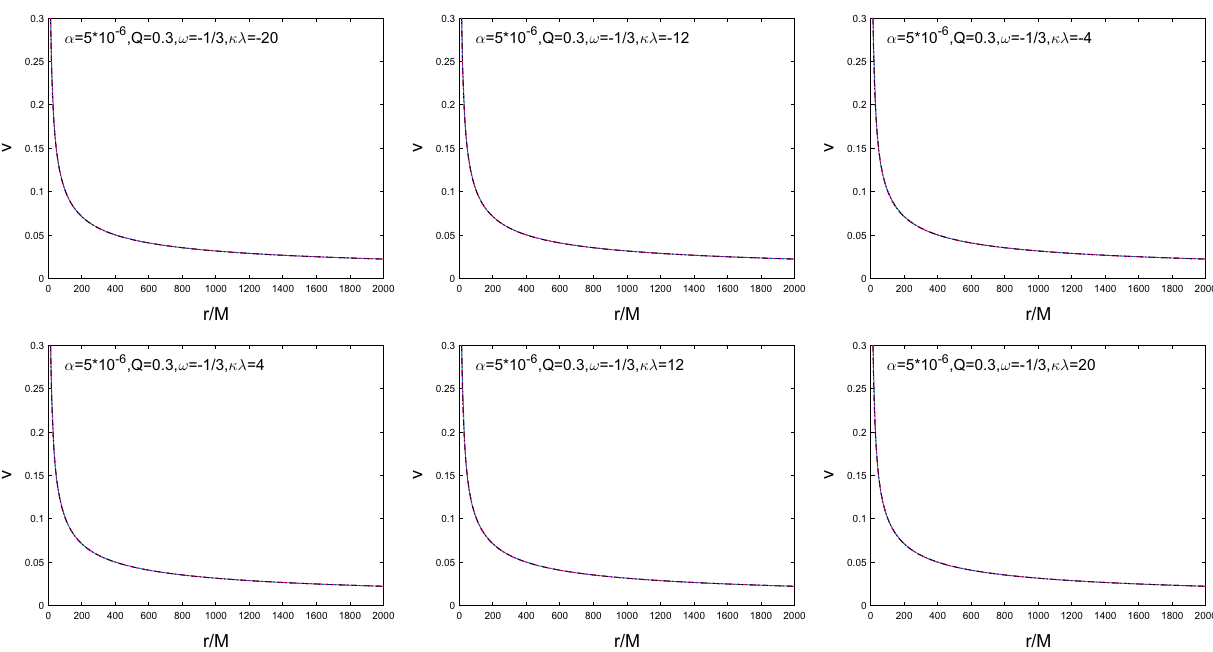
Fig. 4 Curves of the rotation velocity for the KN-AdS black hole surrounded by the perfect fluid dark matter in the Rastall